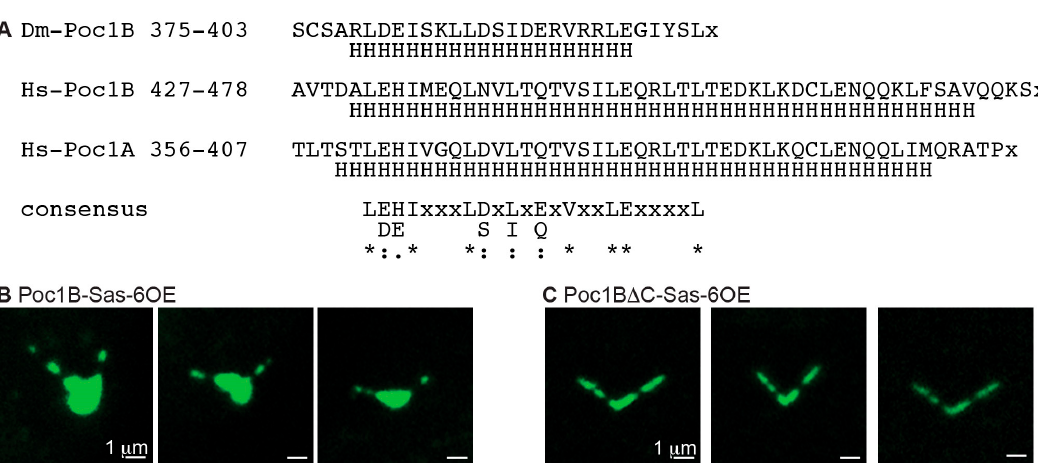
Figure 7. The coiled coil domain of Poc1B is essential to induce ectopic particles. ( A ) The coiled coil region of fly Poc1B is conserved in human Poc1A and Poc1B. The C-terminus of fly (Dm) Poc1B (amino acid residues 375–403), Human (Hs) Poc1B (amino acid residues 427–478), and Human Poc1A (amino acid residues 356–407) has a conserve coiled coil region. This region has a conserved amino acid sequence: LEHIxxxLDxLxExVxxLExxxxL. H; amino acid residue predicted to be part of a coiled coil domain, *; identical amino acid residue, “:”; conserved amino acid residue, “.”; weakly similar amino acid residue, x; stop codon. ( B , C ) While co-overexpression of Sas-6GFP–Poc1BGFP induced ectopic particles in primary spermatocyte ( B ), no particles were observed in co-overexpression of Sas-6GFP–Poc1B ∆ C-GFP (C).